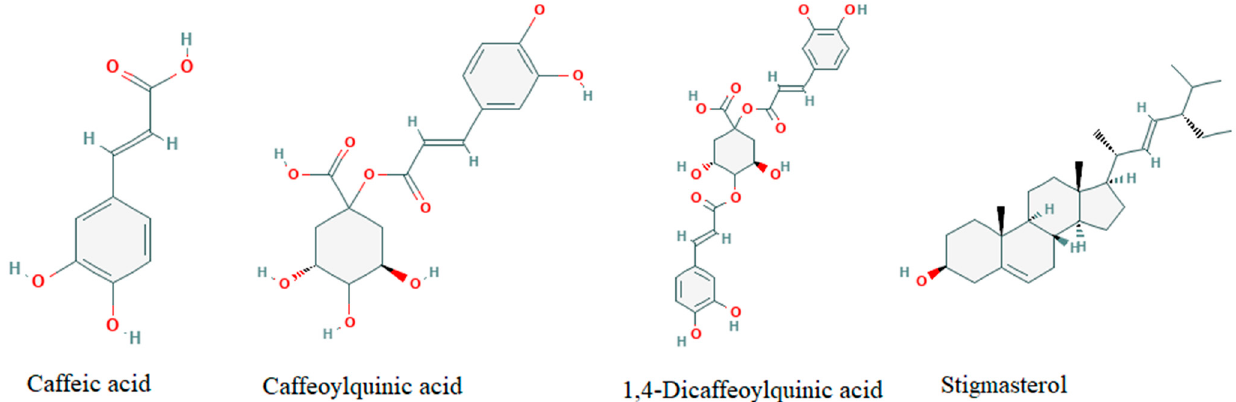
Figure 7. Chemical structures of reducing compounds (Source: pubchem.ncbi.nlm.nih.gov accessed on 16 August 2021).